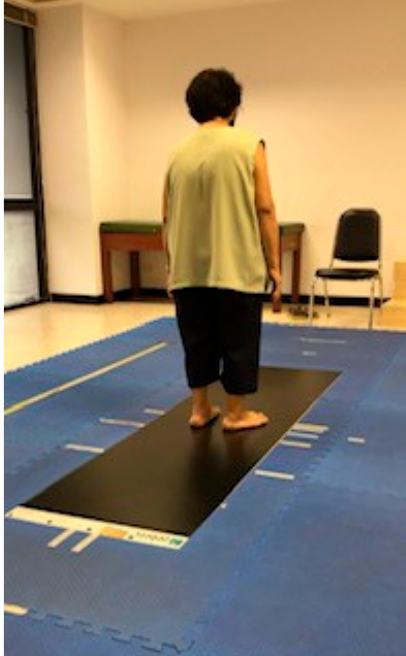
Figure 2. The participant was instructed to walk barefoot at a comfortable